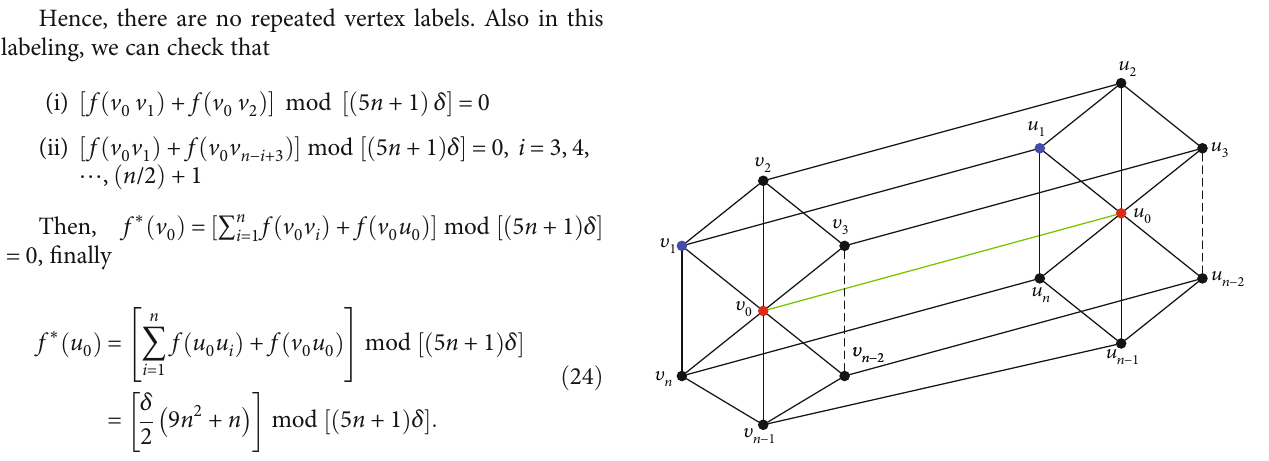
− graceful labeling. Figure 8: The Π 10 with edge 7